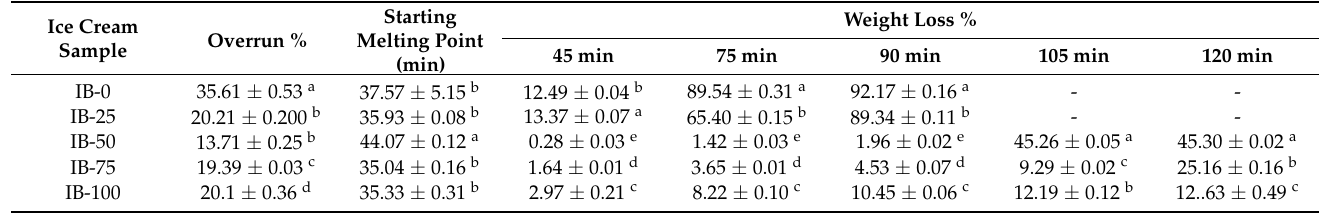
Table 6. Overrun, melting point, and weight loss (%) in interval times during storage for 120 min at 25 ◦ C of ice cream incorporating